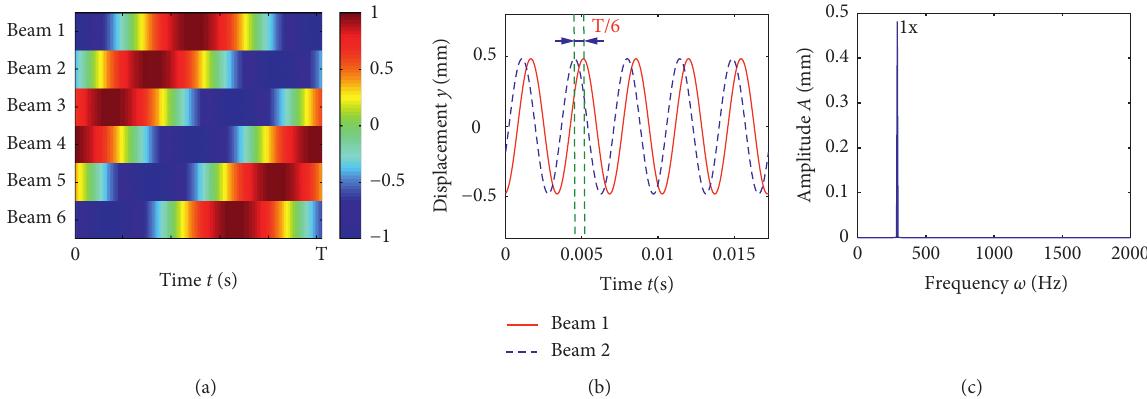
Figure 22: The response of beam root for μ � 0.8: (a) response of beam 1 to 6, (b) response curve of beams 1 and 2, and (c) spectrum plot of beam 1.